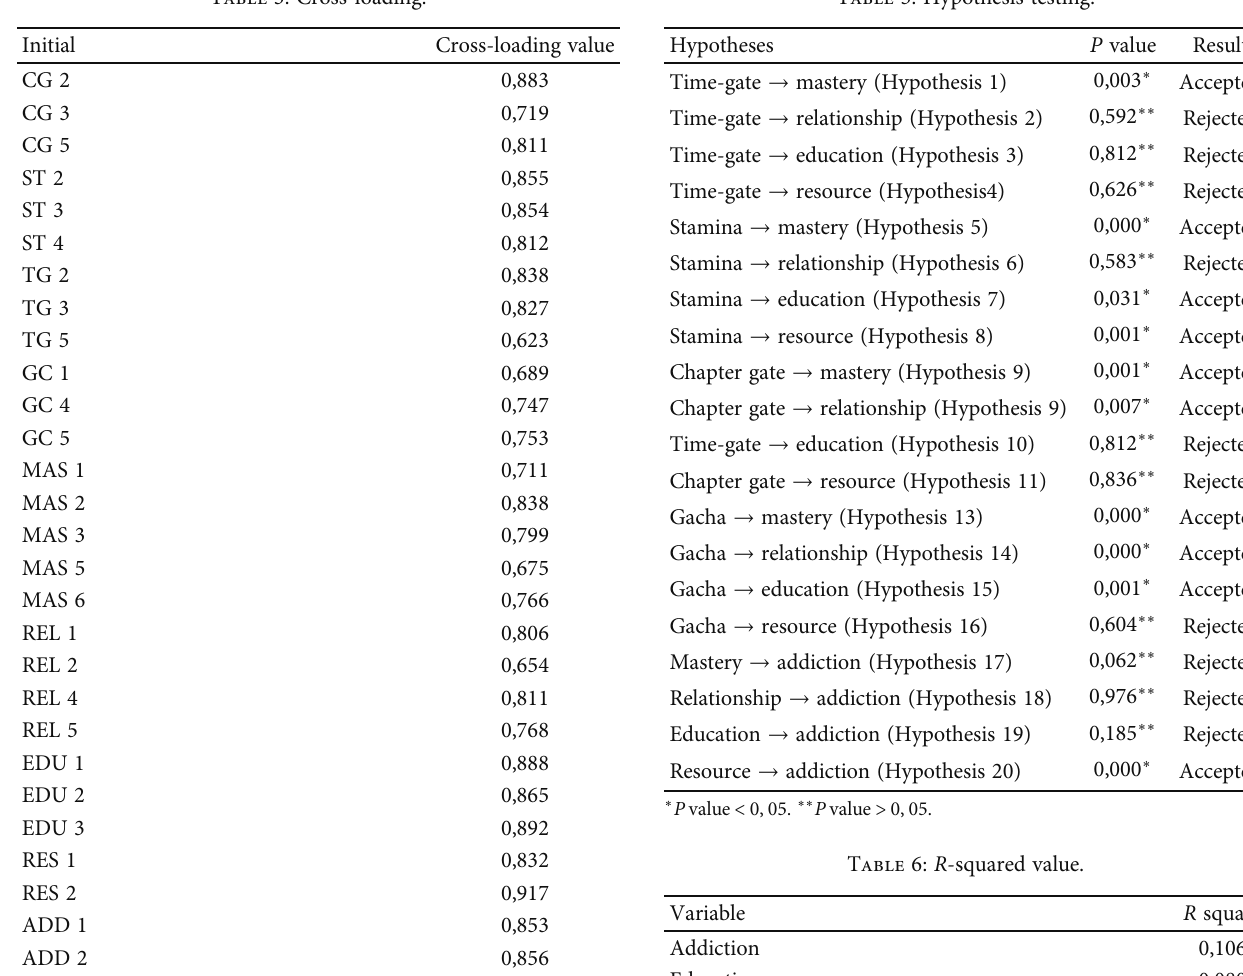
Table 3: Cross-loading.